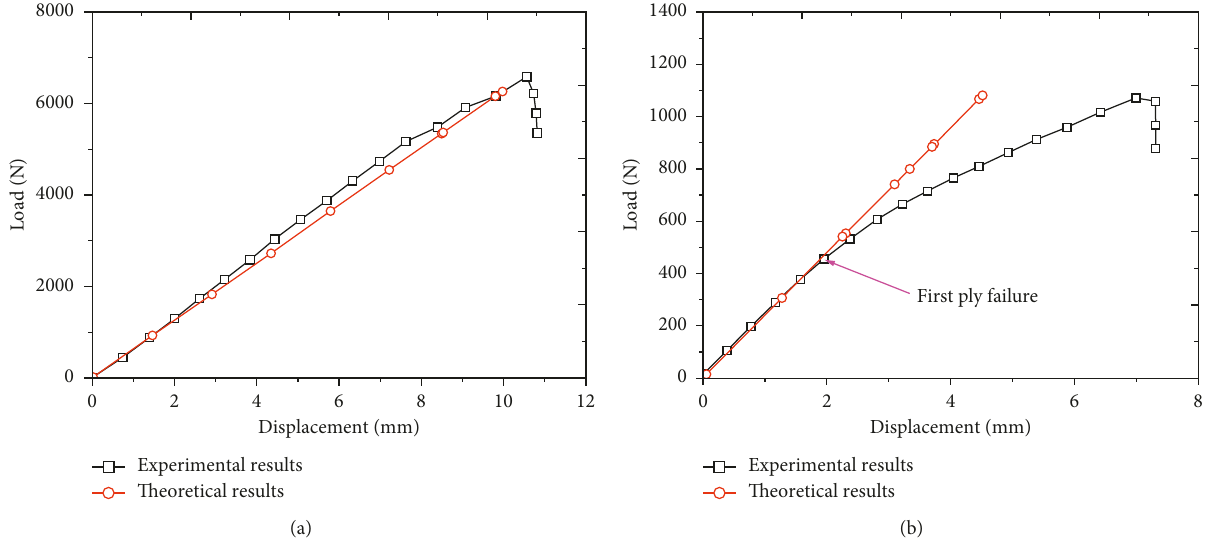
Figure 3: Load-displacement curve. (a) Longitudinal. (b) Transverse.